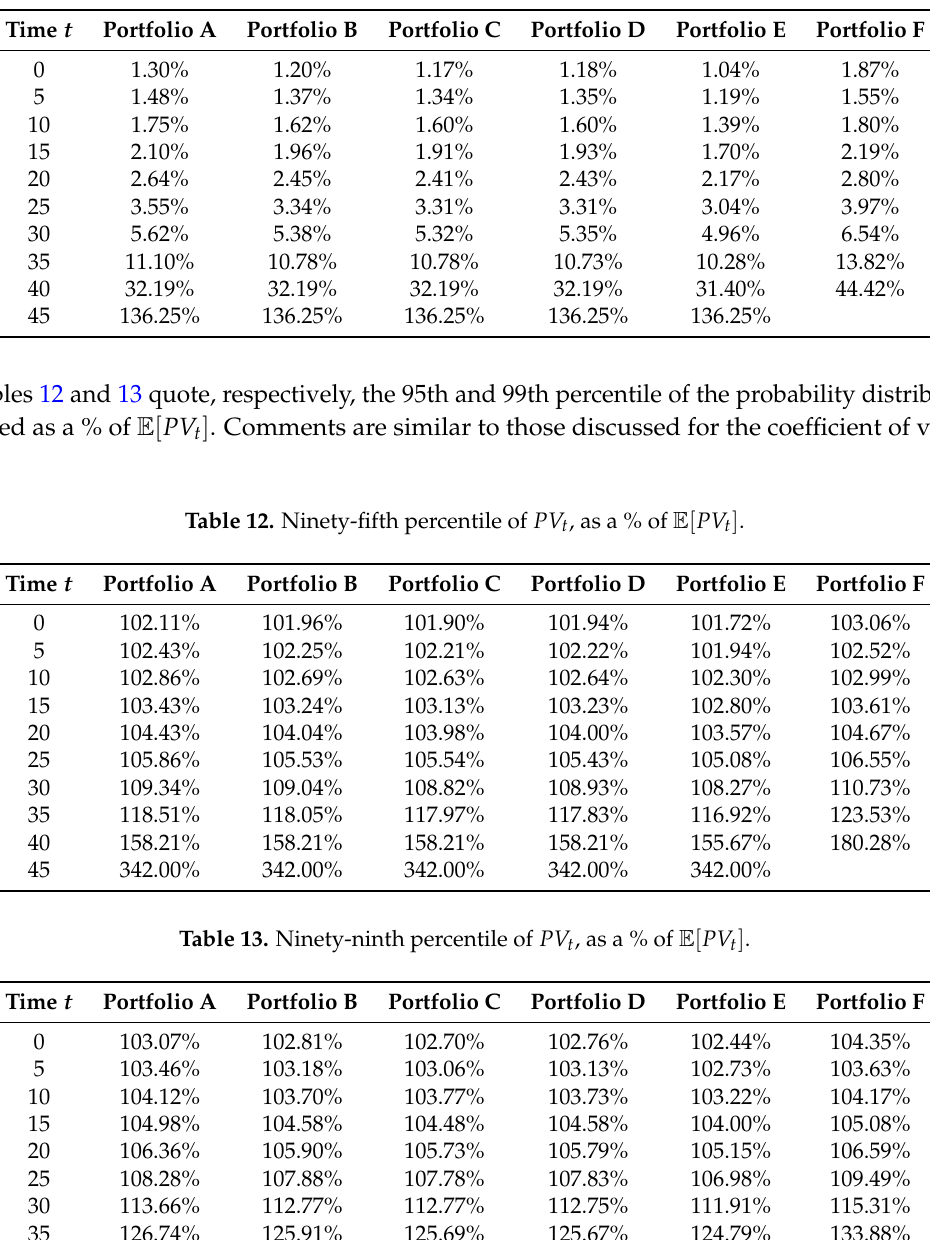
Table 11. Coefficient of variation of the present value of future benefits: CV [ PV t ] .